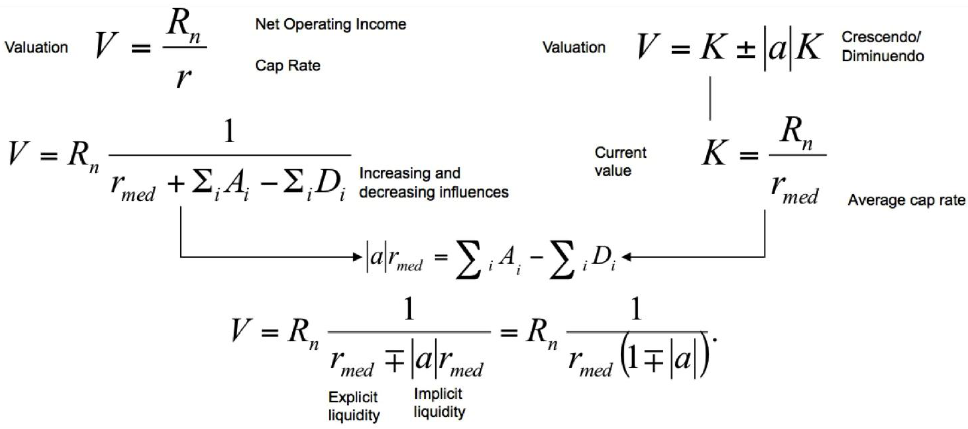
Figure 1. Convergence between the capital theory of Rizzo and the income method of Forte.